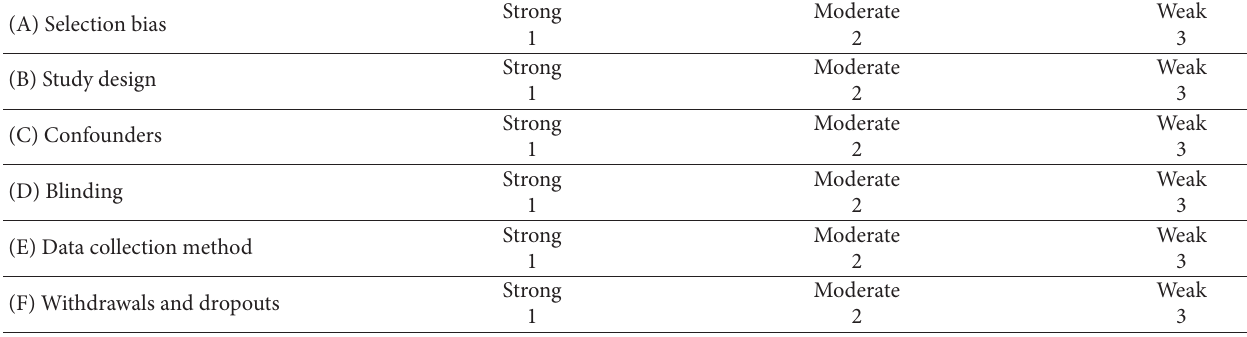
Table 1: EPPHP component and global ratings tool for quantitative